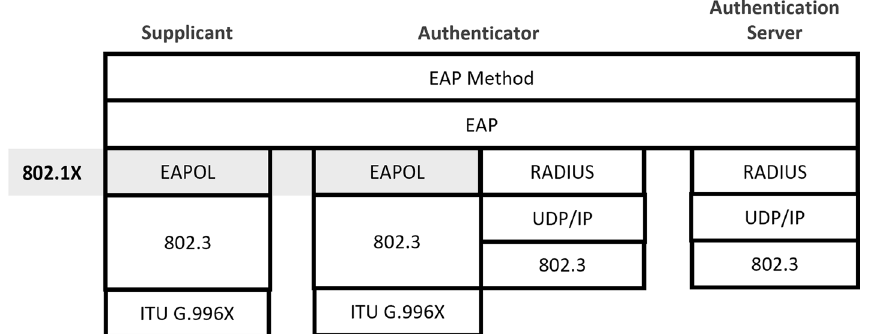
Fig. 9 IEEE 802.1 port-based network access control protocol ×